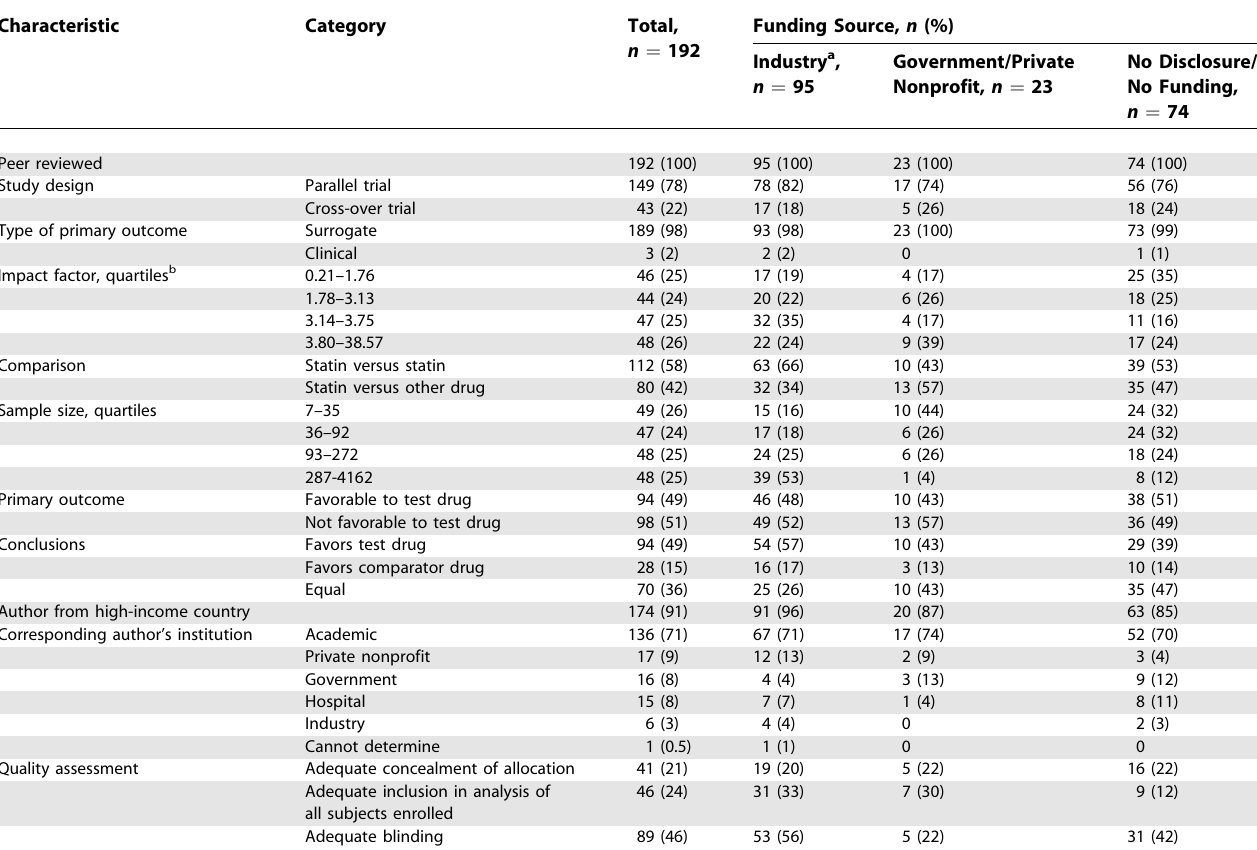
Table 1. Characteristics of Included Articles by Funding Source ( n ¼ 192)